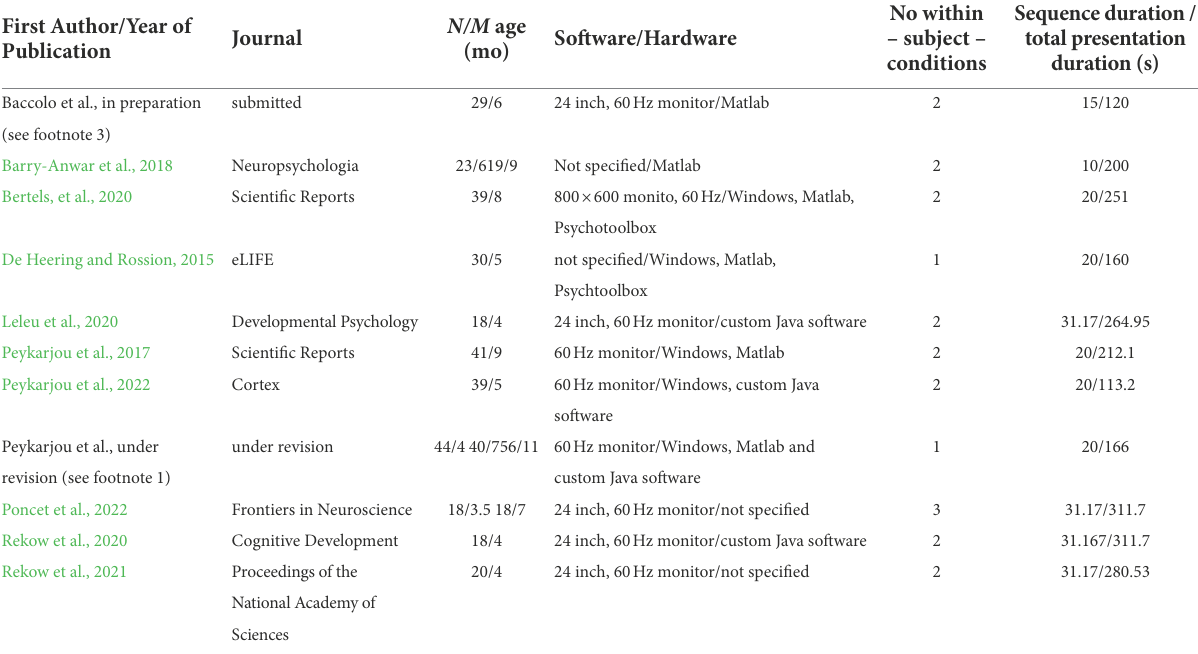
TABLE 1 Design of studies included in the systematic